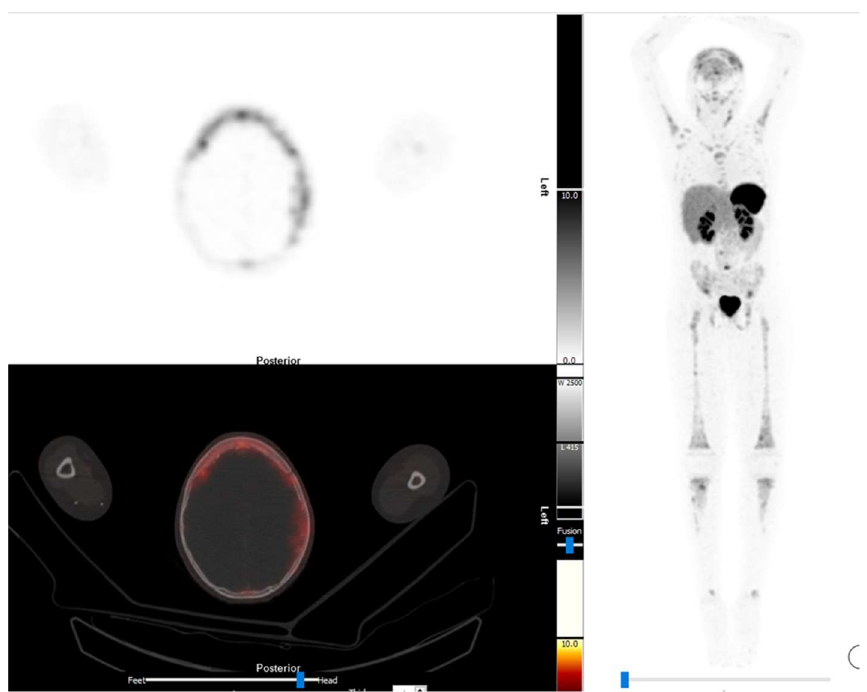
Figure 2. The [ 68 Ga]Ga-DOTANOC images of a 11-year-old boy with stage 4 neuroblastoma